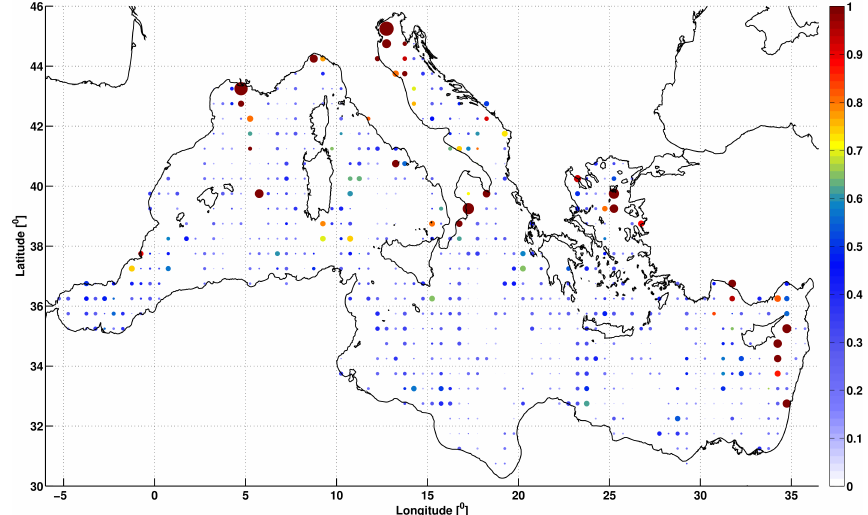
Figure 4. Comparison between simulations and altimeter data for the wave height in the Mediterranean basin. The bubble size indicates the wave height total error in %. The colour scale represents the